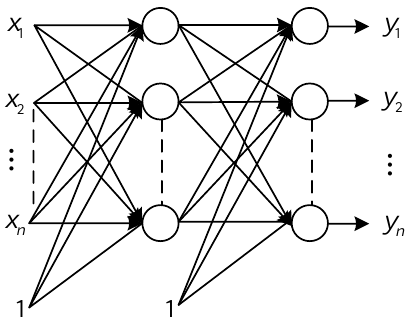
Figure 3. Schematic diagram of AE network structure.